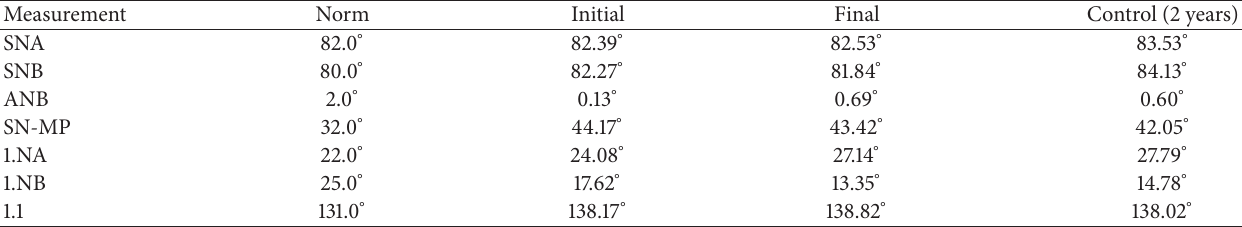
Table 1: Cephalometric analysis